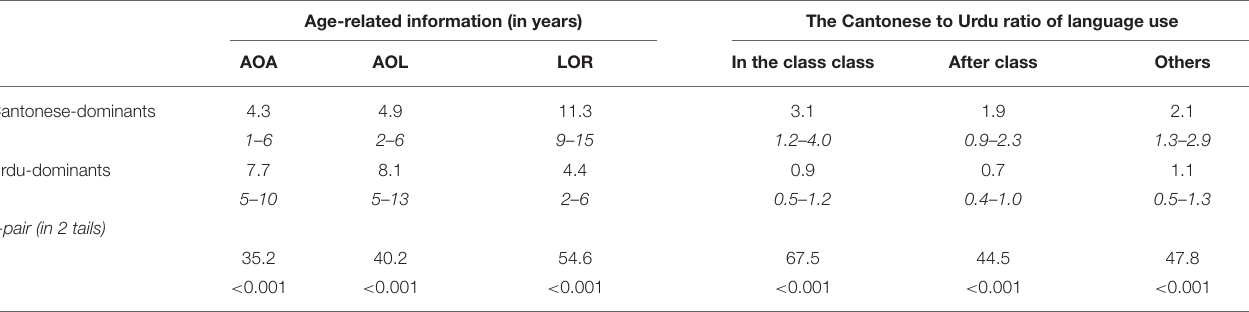
TABLE 1 | Individual information (mean values and ranges) of AOA, AOL, LOR, and the Cantonese to Urdu ratio of language use for bilinguals in terms of different occasions (home, school, others). Age-related information (in years) The Cantonese to Urdu ratio of language use AOL LOR In the class class After class Others